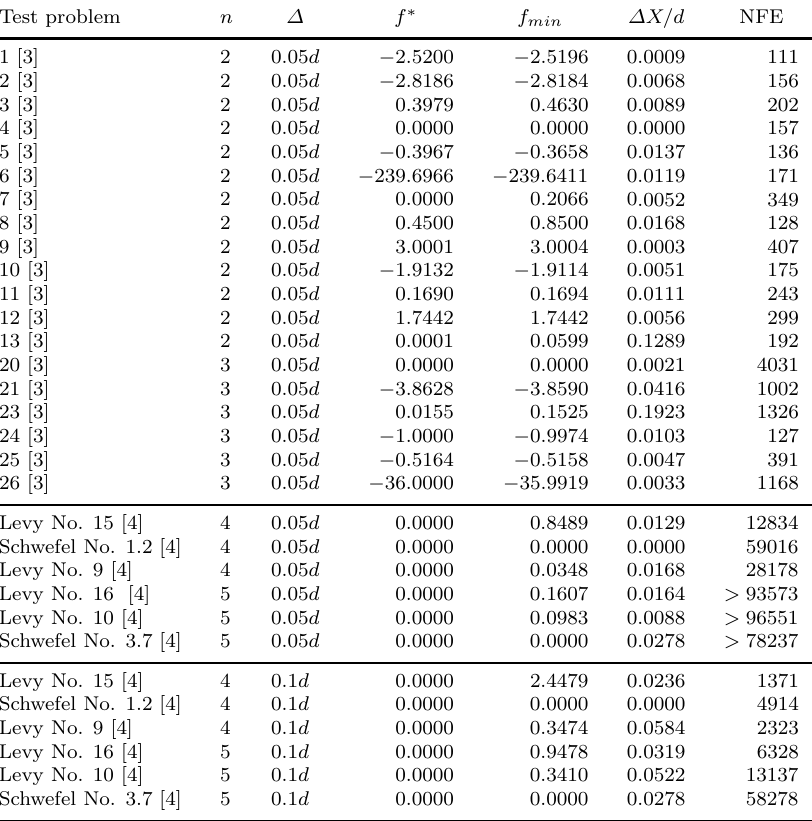
Table 1. Results of experimental investigation Test